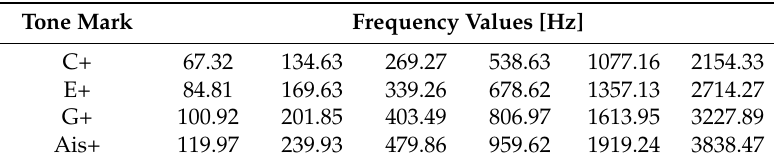
Figure 7. Testing tracks, size of room 20 m × 10 m. Table 2. Transition results of tested persons on 5 different routes in “no learning” mode. Type of Test